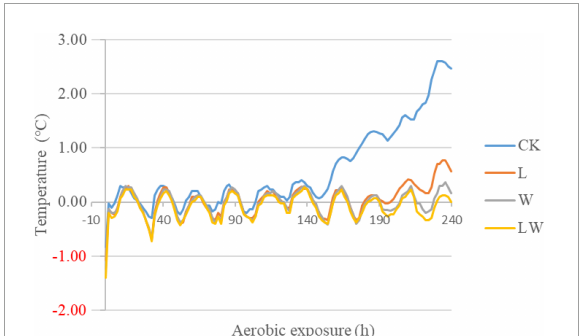
FIGURE1 The degree of silage temperature ( ◦ C) above ambient temperature in Leymus chinensis silage during aerobic exposure ( n = 3). CK, ensiling L. chinensis with 2.00 ml/kg fresh weight (FW) of distilled water; L, ensiling L. chinensis with 2.00 g/t FW of lactic acid bacteria (LAB) inoculant and 2.00 ml/kg FW of distilled water; W, ensiling L. chinensis with 100 ml/kg FW of distilled water; LW, ensiling L. chinensis with 2.00 g/t FW of LAB inoculant and 100.0 ml/kg FW of distilled water.